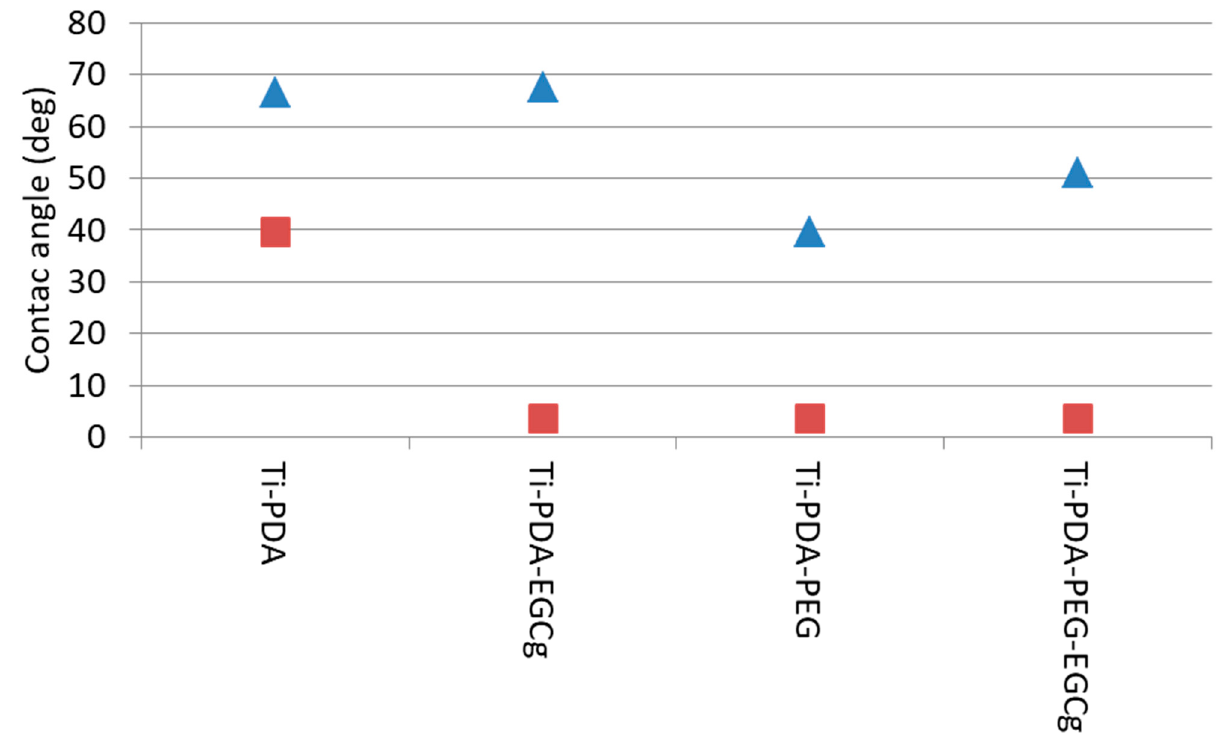
Figure 6. Measured advancing (triangle) and receding (square) angles on tested samples.